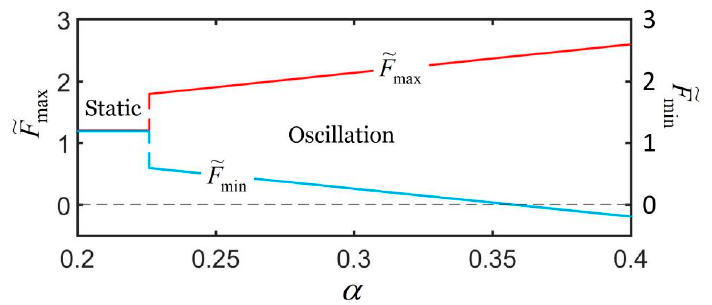
Figure 6. Dependence of maximum and minimum dimensionless spring force on the contraction coefficient. The parameters are (cid:101) I = 0.32, (cid:101) k = 5.8, (cid:101) c = 0.23, (cid:101) g = 1.2, (cid:101) L p = 1.1, (cid:101) u 0 = 0, and (cid:101)